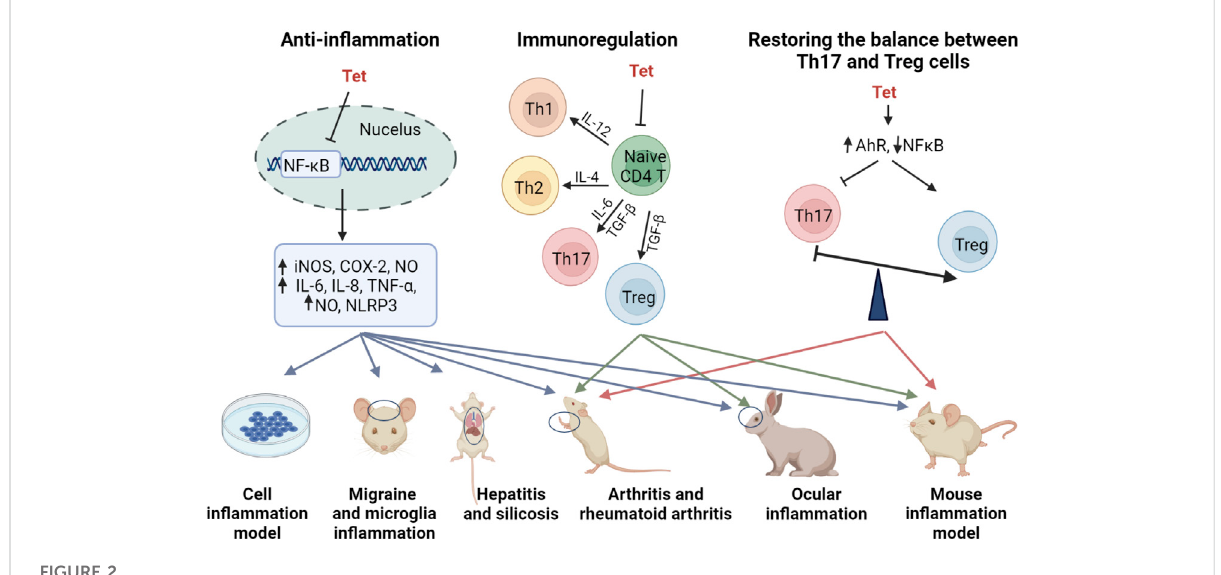
FIGURE 2 Anti-in fl ammatory molecular mechanism of